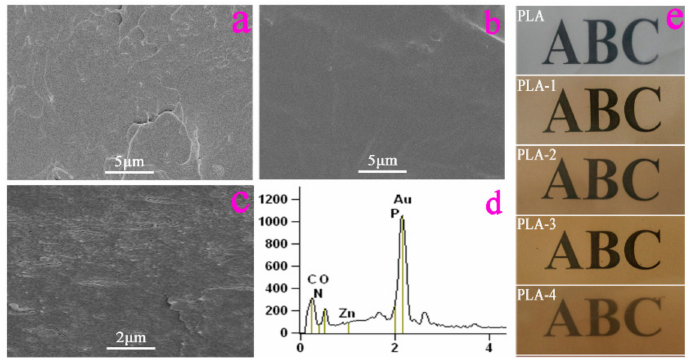
Figure 2. ( a ) Scanning electron microscope (SEM) of pure poly (lactic acid) (PLA); ( b , c ) SEM of PLA-2; ( d ) EDS of PLA-2; ( e ) Optical images of the prepared